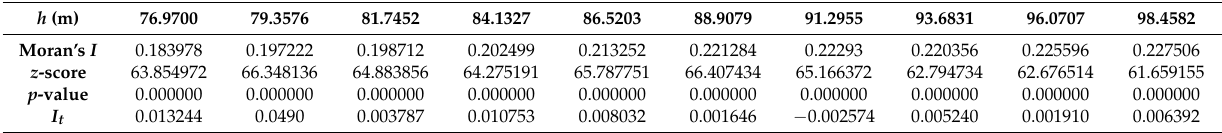
Table 6. Result of Moran’s I Calculation According to Cluster Size at Level 12.